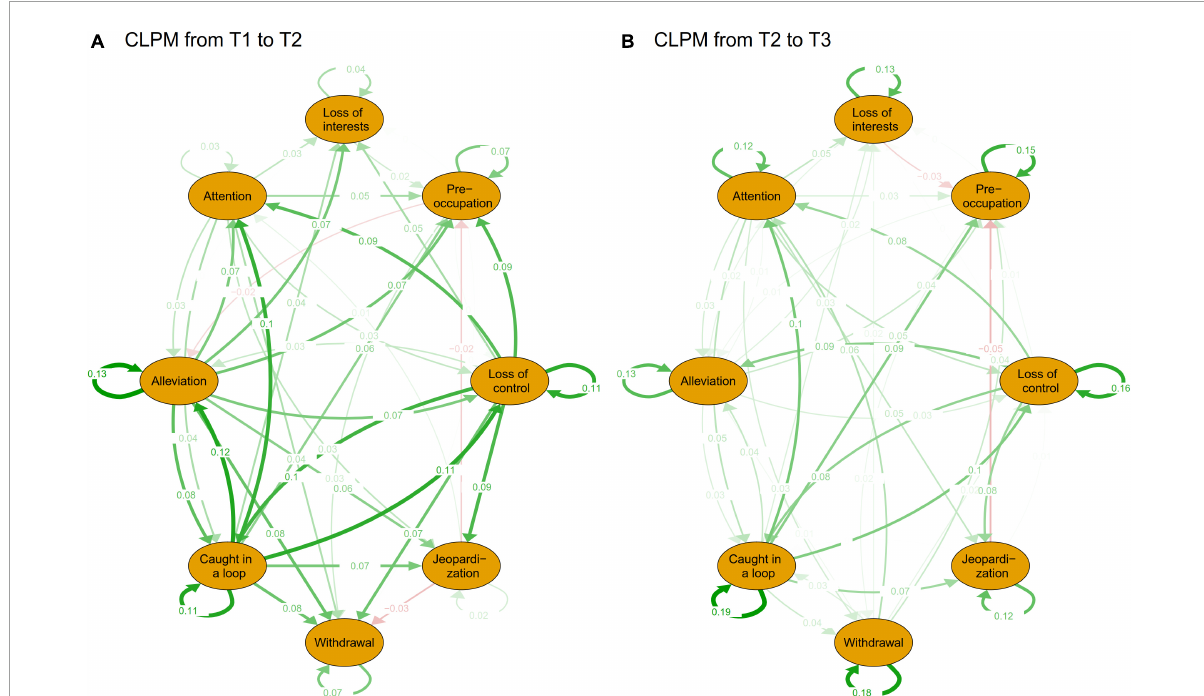
FIGURE1 The CLPM of PSU of T1 to T2 and T2 to T3. (A) Is the CLPM from time 1 to time 2 and (B) is the CLPM from time 2 to time 3. CLPM is a cross-lagged panel model. Green paths represent positive prediction and red path means negative prediction. For comparison, the layout is set to “circle.” The node paths directed to themselves are autoregressive paths and the rest are cross-lagged